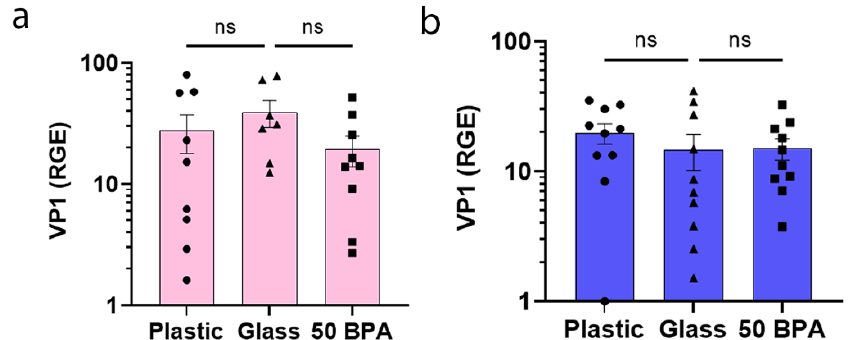
Figure 2. Plastic caging or BPA did not increase cardiac VP1 viral gene expression during